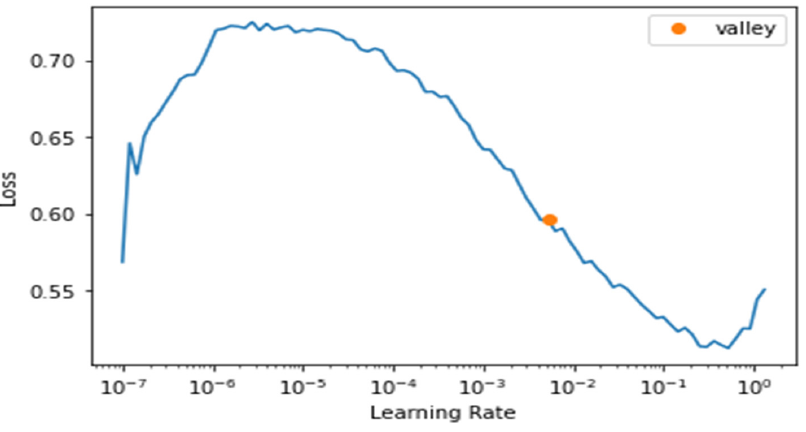
Figure 11. Learning Rate and Loss of fastai.